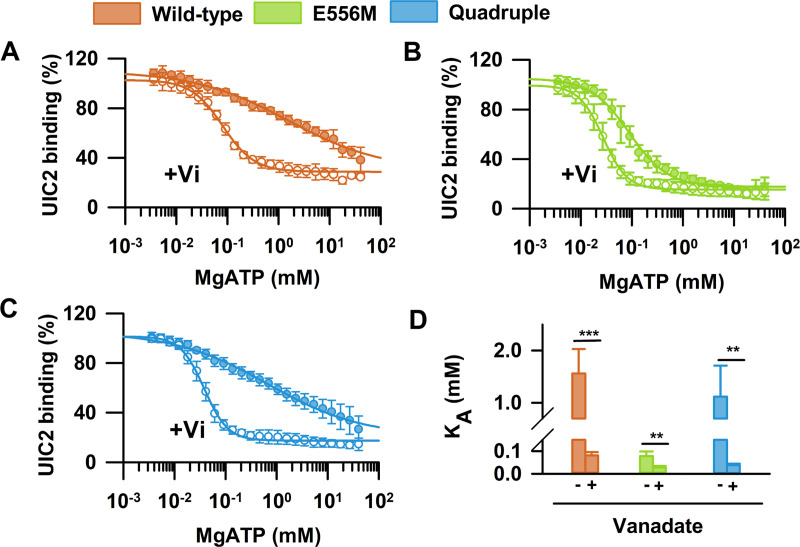
MgATP dependent UIC2 binding.NIH 3T3 cells expressing ABCB1 variants were permeabilized to allow for systematic variation of intracellular nucleotide concentrations. Dose-response curves of UIC2 binding with increasing concentrations of MgATP in the absence or presence of vanadate (Vi) were obtained for (A) wild-type, (B) the catalytic glutamate mutant and (C) the quadruple mutant. Dose-response curves were normalized to the UIC2 signal obtained in the presence of 0 mM ATP, which was found practically equal to the F/P corrected 15D3 signal and did not differ between the different ABCB1 variants. Panel (D) summarizes the mean apparent nucleotide affinity values (KA ± SD, n = 9–11) obtained in control and Vi treated cells. Statistical comparison of the KA values of Vi treated and untreated samples was carried out by unpaired Student's t-test (two-tailed test); ***p<0.001, **p<0.01.